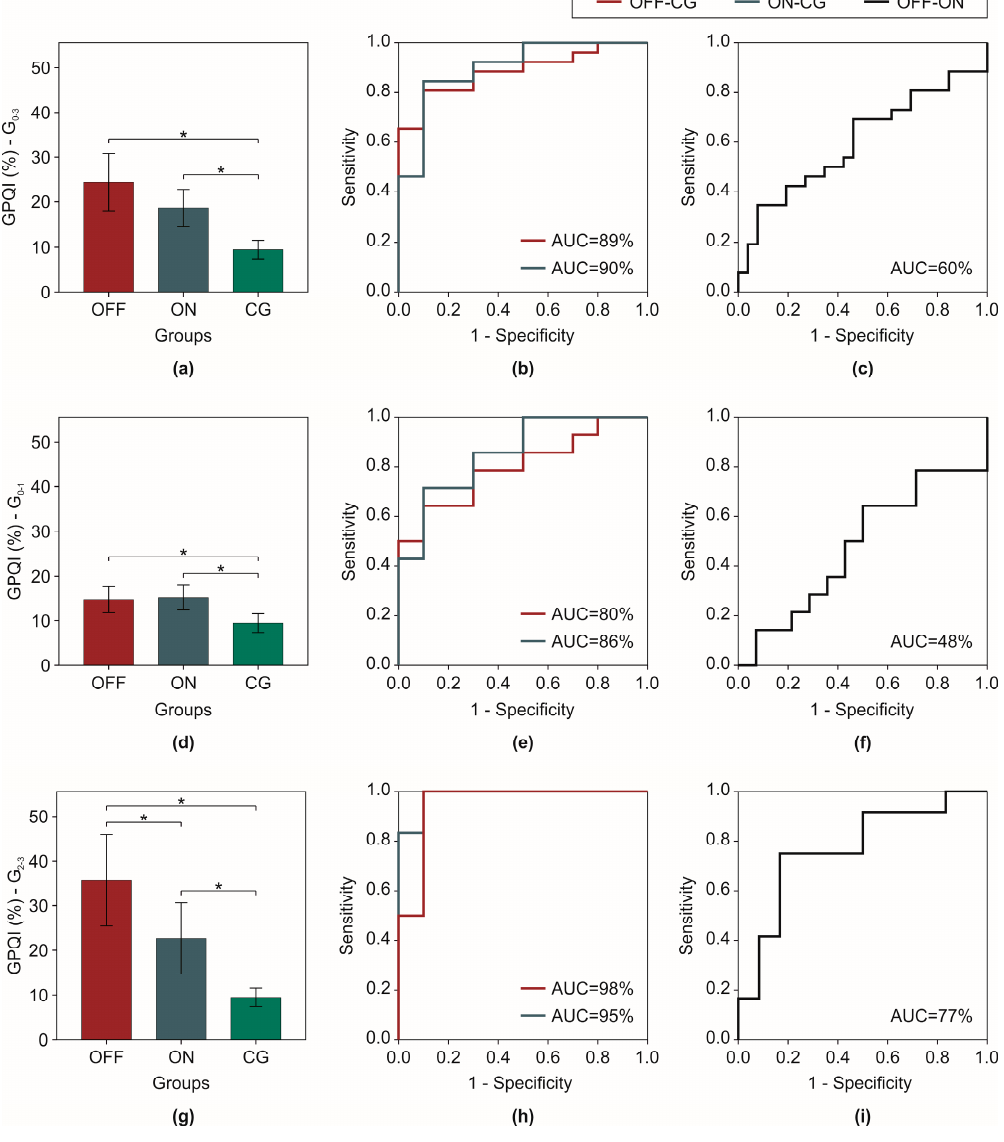
Figure 2. ( a , d , g ) Mean and Standard Error of GPQI of patients in both condition (OFF, ON) and control group (CG); ( b , e , h ) ROC analysis of GPQI for OFF vs CG and ON vs CG; ( c , f , i ) ROC analysis of GPQI for OFF vs ON. Each chart type is reported for three subgroups, G 0–3 , G 0–1 and G 2–3 , respectively.